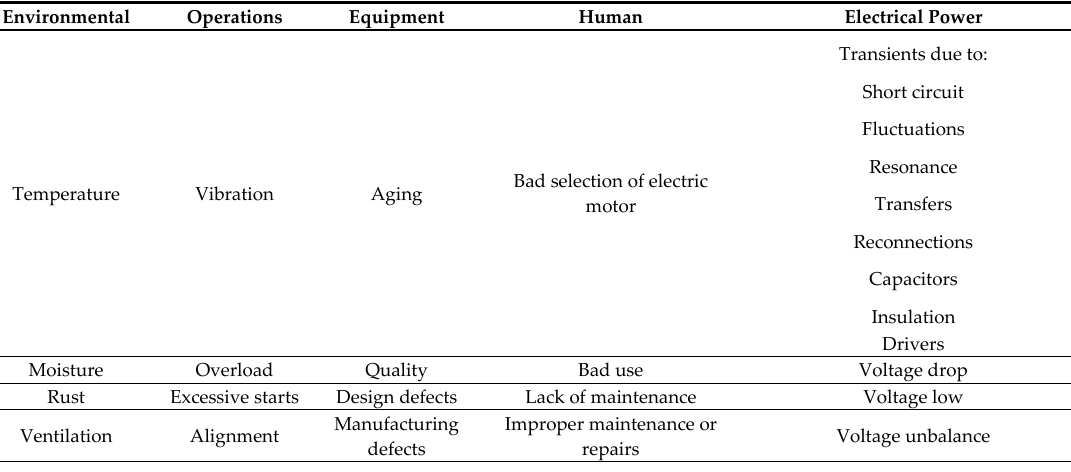
Table 1. Factors causing the failures of induction